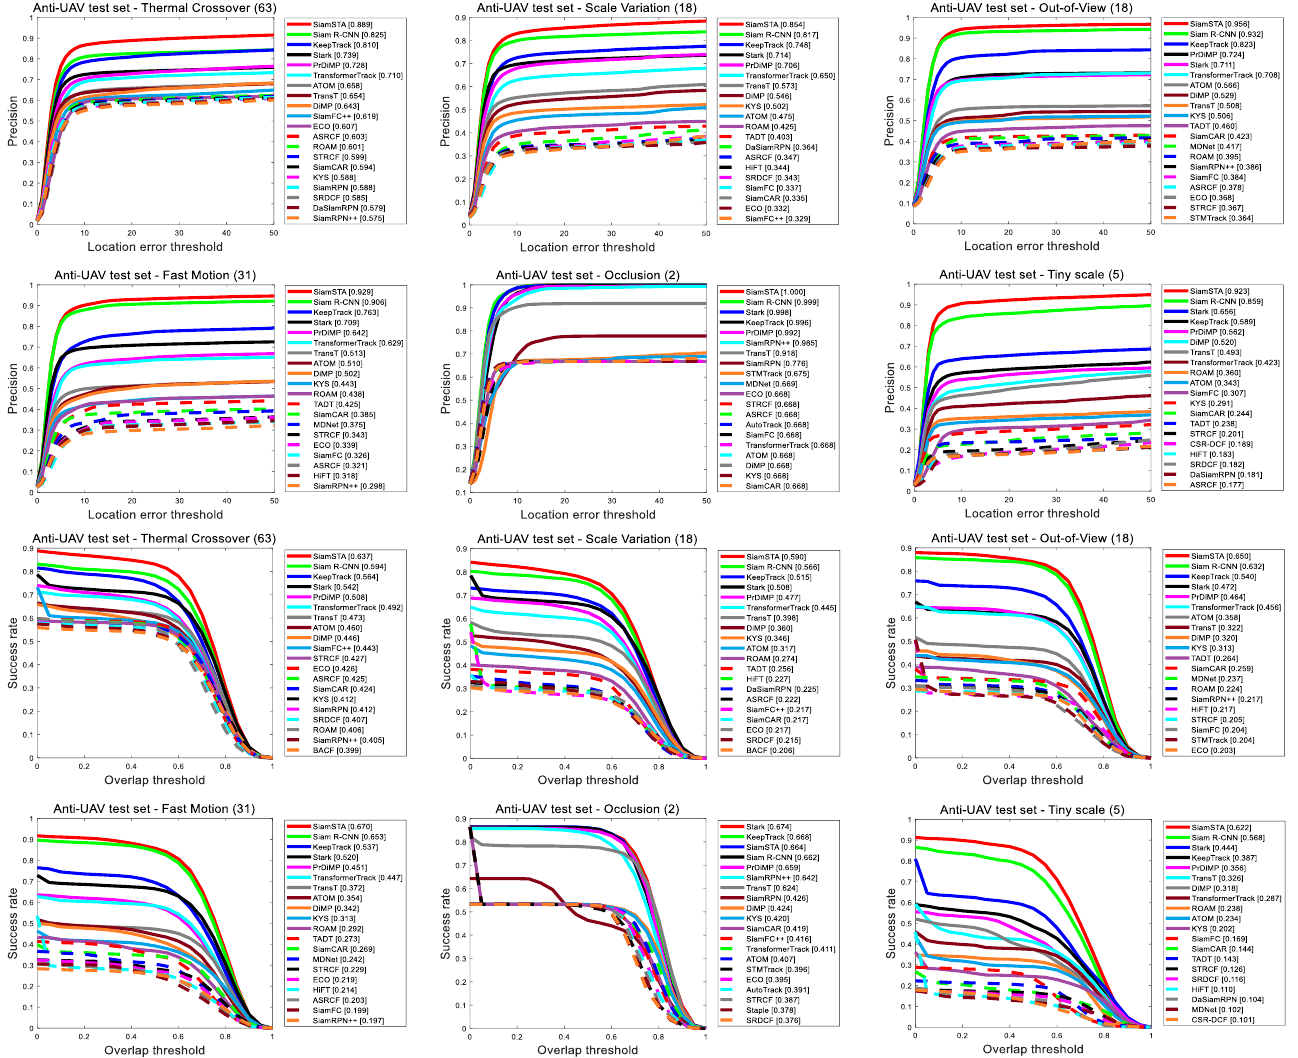
Figure 7. Precision and success plots of our SiamSTA and state-of-the-art trackers on the different attributes defined in Anti-UAV [16] test set. The mean precision and AUC scores are reported for each tracker. Best viewed in color and